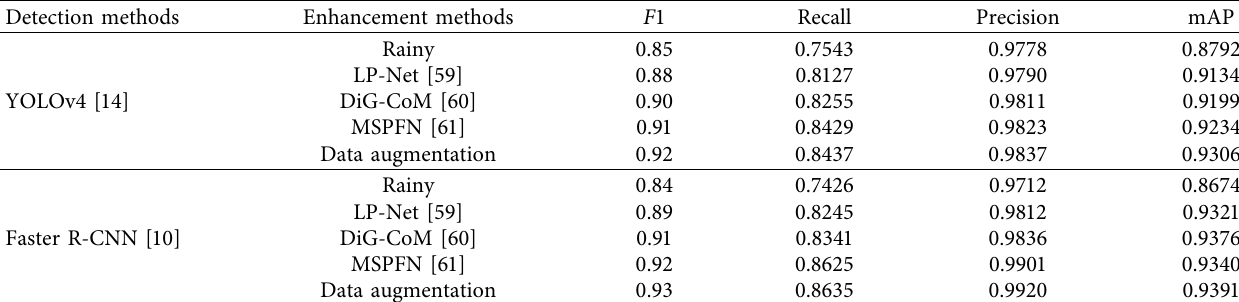
Table 4: The influences of rainy imaging condition and visibility enhancement on water-surface garbage detection. Detection